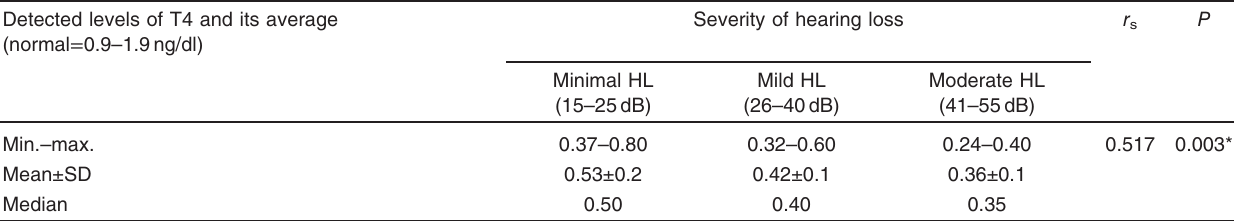
Table 6 Correlation between the severity of hearing loss and the levels of the relevant T4 among 54 ears with hearing impairment Detected levels of T4 and its average (normal = 0.9 – 1.9ng/dl)